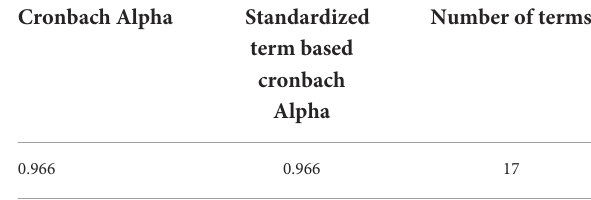
TABLE 7 Reliability coefficient of overall reliability. TABLE 8 Kaiser-Meyer-Olkin (KMO) and Bartlett